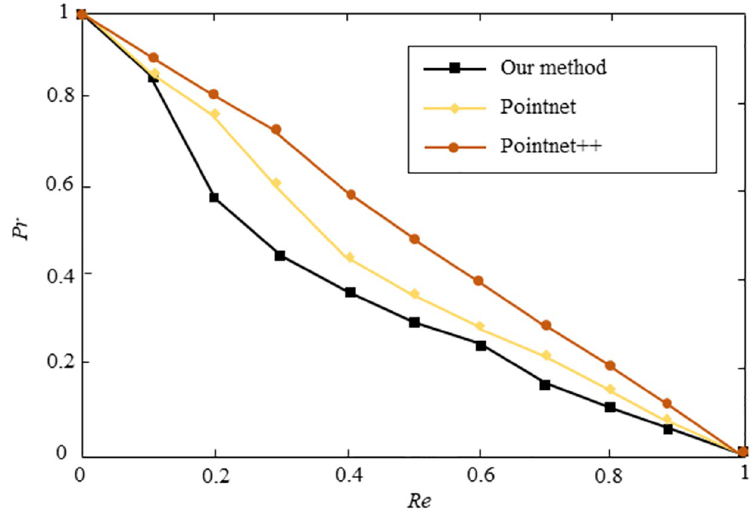
Fig 6. Performance of our method, PointNet, and PointNet++ when the training dataset contains 60 3D models. The horizontal axis represents recall rate, and the vertical axis represents precision rate. Higher curves represent better performance.